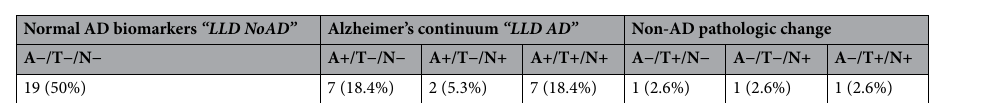
Table 1. Combinations of CSF AD parameters in the LLD group. A+ = pathologic Amyloid beta42/40; T+ = pathologic phosphorylated Tau; N+ = pathologic marker of neurodegeneration (here total Tau).